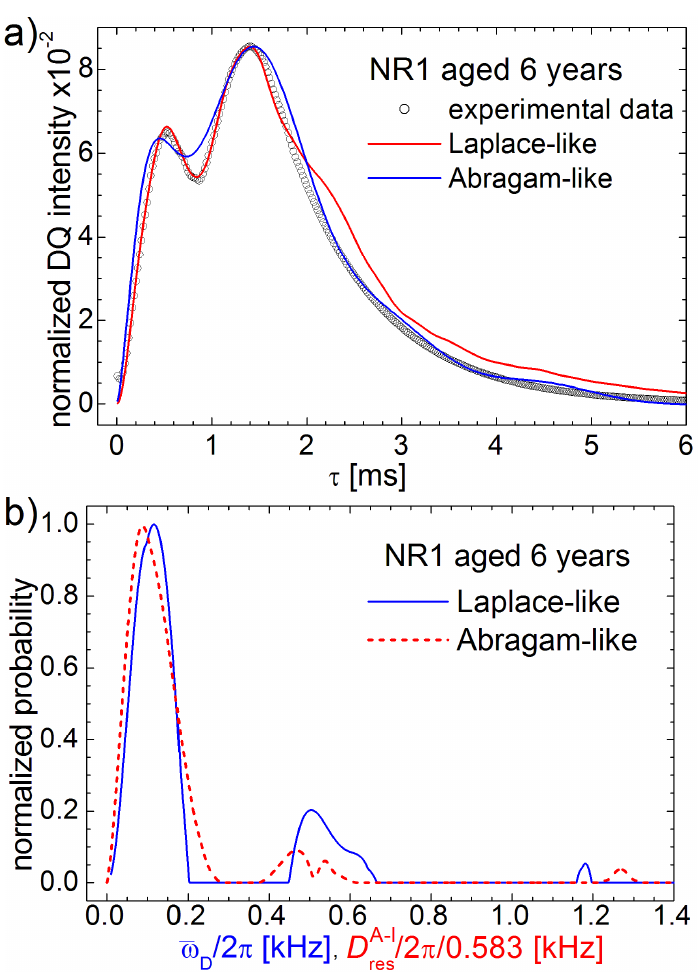
Figure 15. The comparison of DQ Laplace-like (continuous blue line) and Abragam-like (dashed red line) of ( a ) DQ build-up curve and ( b ) spectra measured for the NR1 natural rubber sample, naturally aged during six years. The spectra were renormalized in order to have the maximum value equal to one. Laplace-like spectrum is represented in function of averaged residual dipolar coupling, ω D /2 π while the Abragam-like spectrum is represented in function of D A − l res /2 π